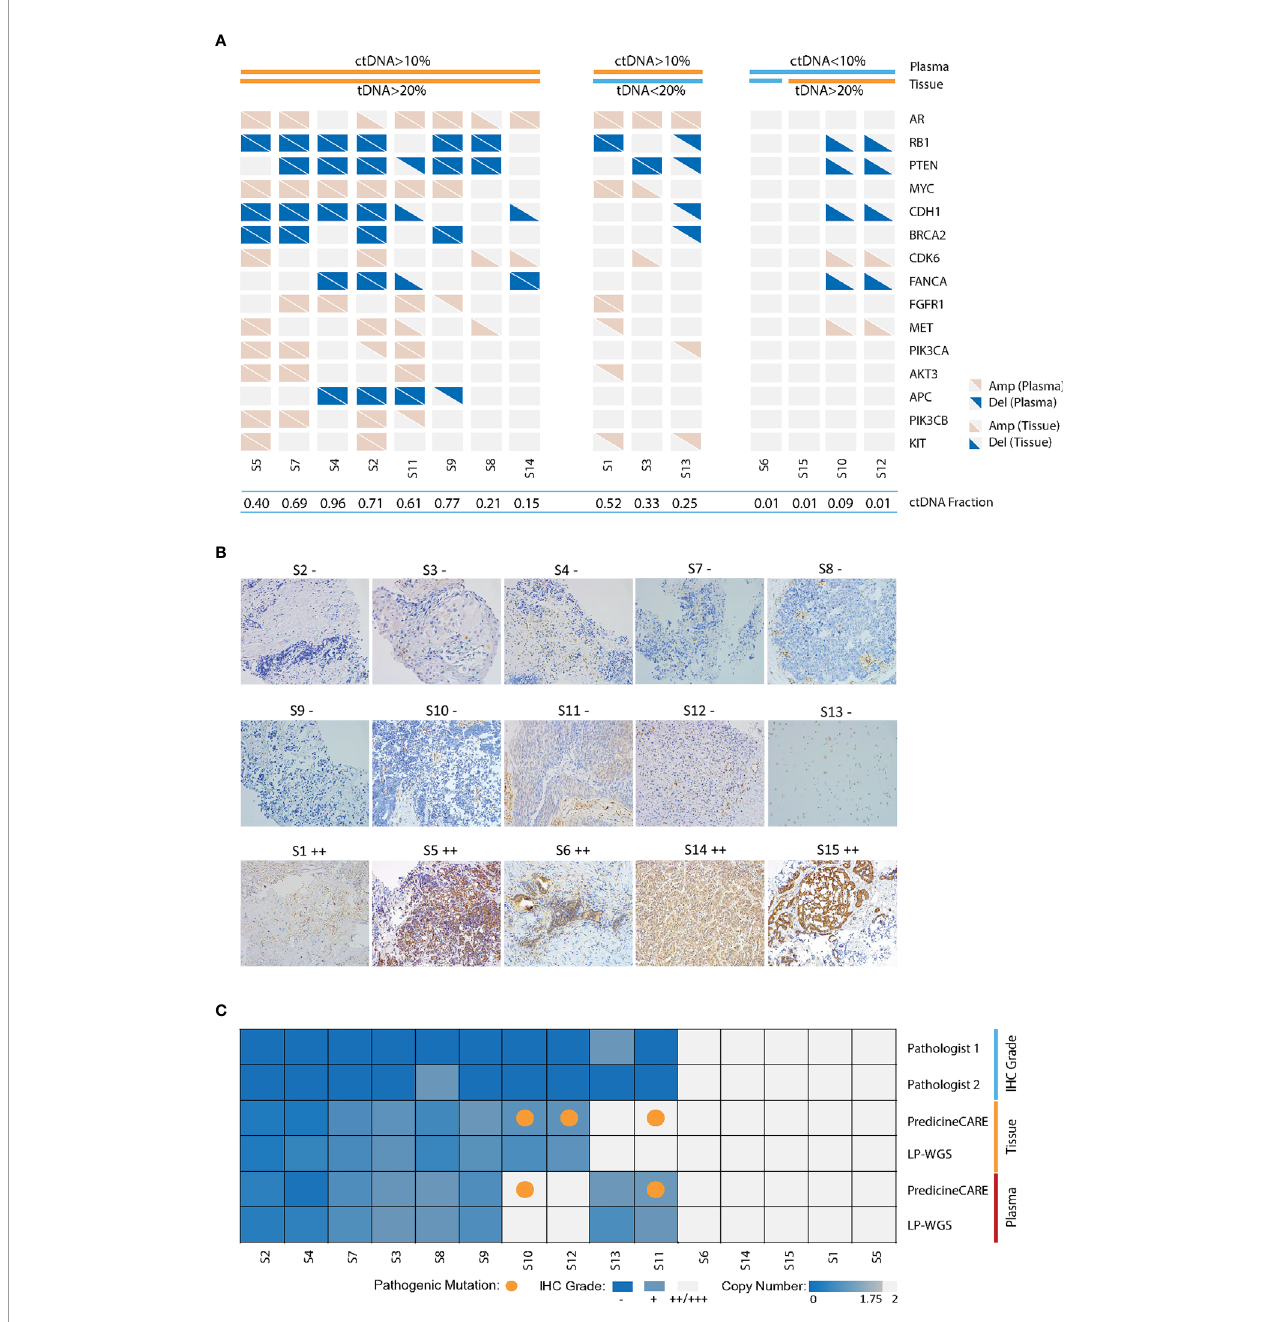
FIGURE 1 | Validation of cfDNA-based gene copy number variation. Paired tumor tissue-plasma samples collected from 15 metastatic castration-resistant prostate cancer patients were analyzed by PredicineCARE, LP-WGS, and IHC assays. (A) Landscape of gene copy number variations, including ampli fi cation and deletion events detected by the PredicineCARE assay in tissue and plasma samples. Genes altered in >10% of the samples are shown. Samples are grouped according to circulating tumor DNA (ctDNA) and tissue tumor DNA (tDNA) fractions. ctDNA fractions were estimated by LP-WGS and mutation allele frequency reported by the PredicineCARE assay. Tissue tumor cell percentages (tDNA) were estimated by pathological reviews. Amp, gene ampli fi cation (copy number gain); Del, gene deletion (copy number loss). (B) PTEN expression in 15 prostate cancer tissues as detected by immunohistochemistry (×20). Pathology score was de fi ned as the product of a staining intensity score (0 – 3) and stained area score (0 – 3). If the score was ≤ 1, the sample was characterized as negative ( − ). If the score was >1, the result was positive (Score 1 – 3, grade +; Score 4 – 6, grade ++; Score 7 – 9, grade +++). Two pathologists reviewed the slides independently, and the average score was considered as the fi nal score for a given case. (C) Agreement of PTEN loss between tissue and blood-based detection for the 15 pairs of samples. “ IHC grade ” shows PTEN protein expression by immunohistochemical staining. PTEN gene copy loss at the DNA level was evaluated in tissue and plasma samples using the PredicineCARE assay and low-pass whole-genome sequencing assay